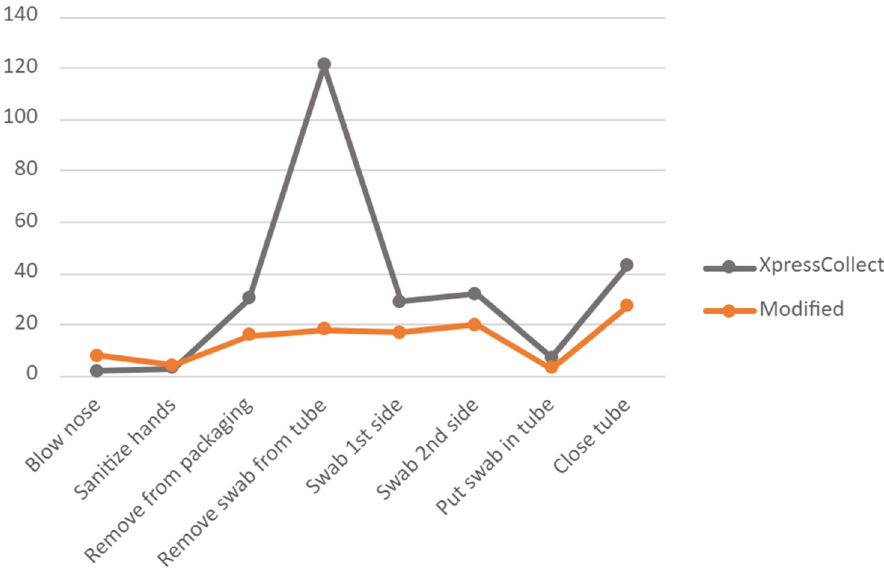
Figure 8. Comparison of observed use problems between XpressCollect and modified swab concept B in Phase 3.